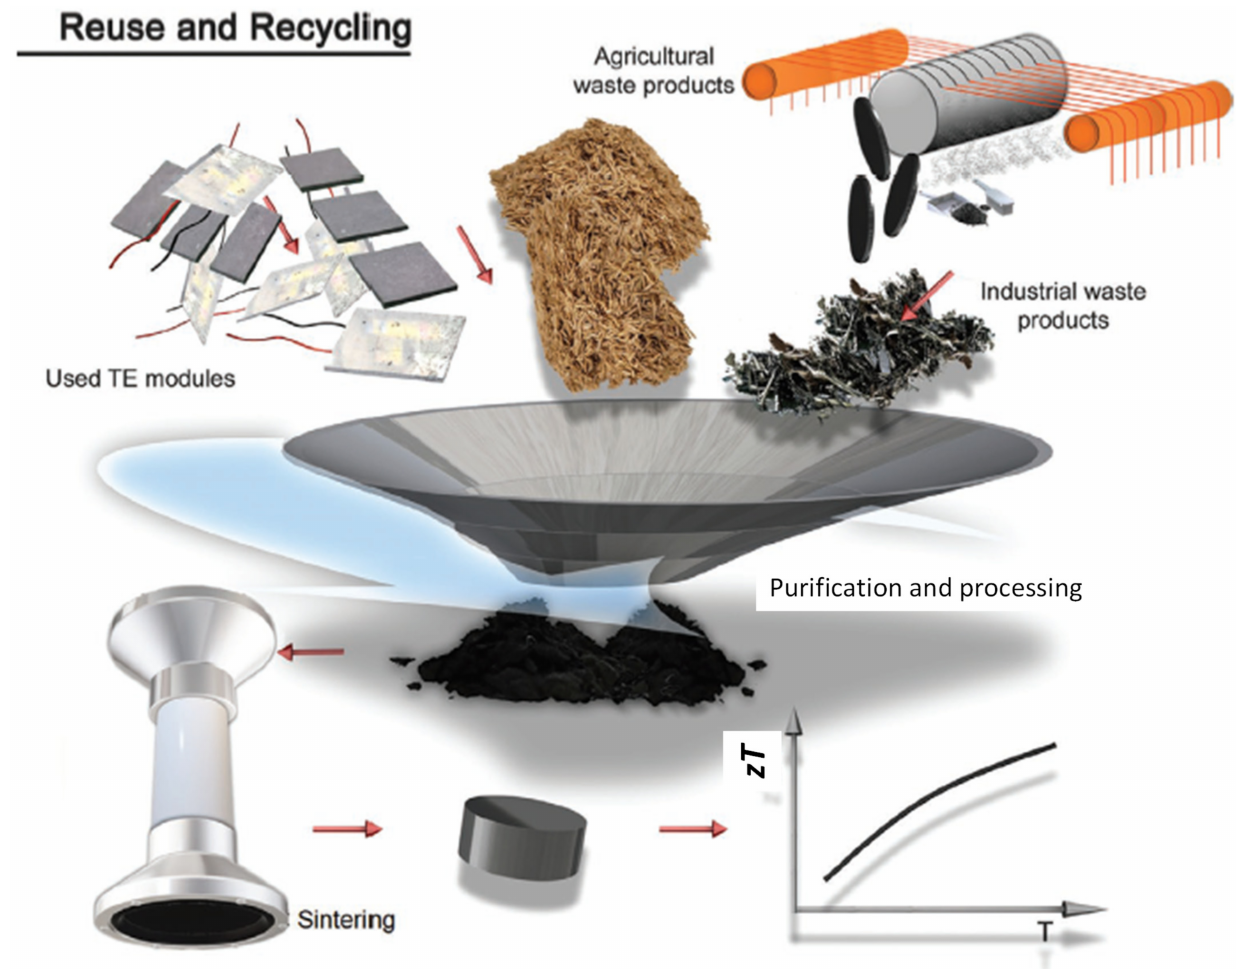
Figure 4. Schematic showing waste upcycling of industrial and agricultural waste into thermoelectrics. Figure from Bahrami et al. [125]. Copyright 2020, Wiley (Weinheim,